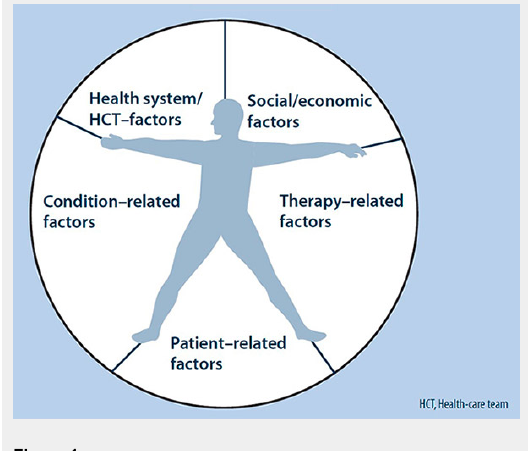
The five dimensions of adherence (reproduced with the permission of the WHO from Sabaté E (2003)